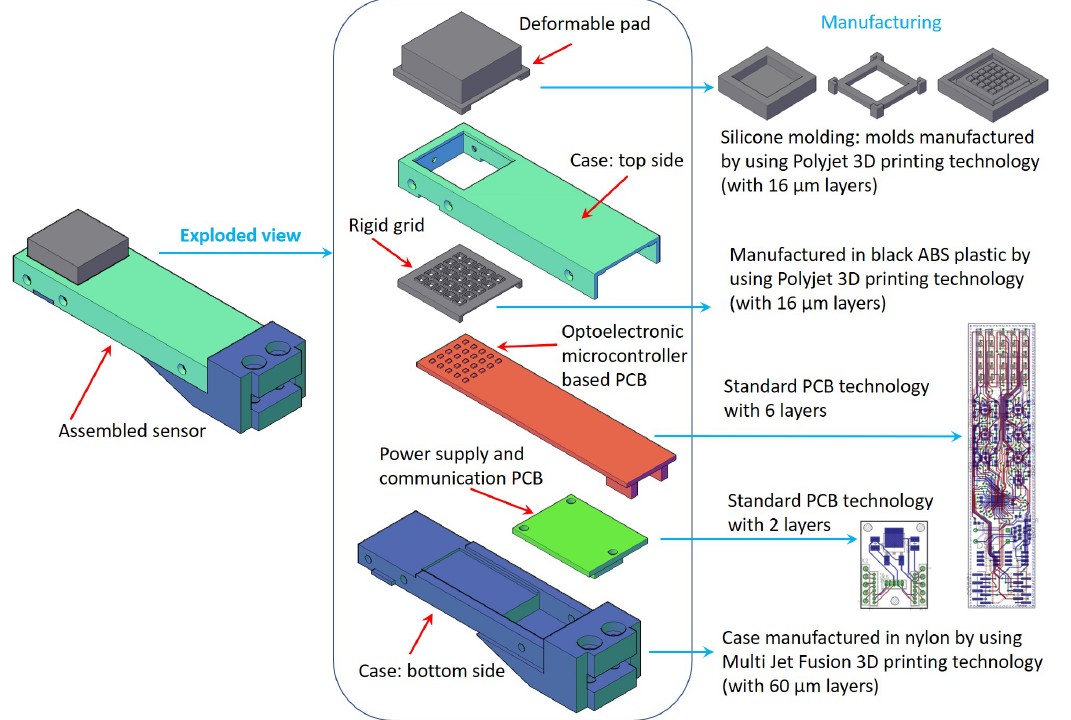
Figure 1. CAD drawing of an assembled sensor ( left ) with all components ( middle ) and details about 3D machines used for the production ( right